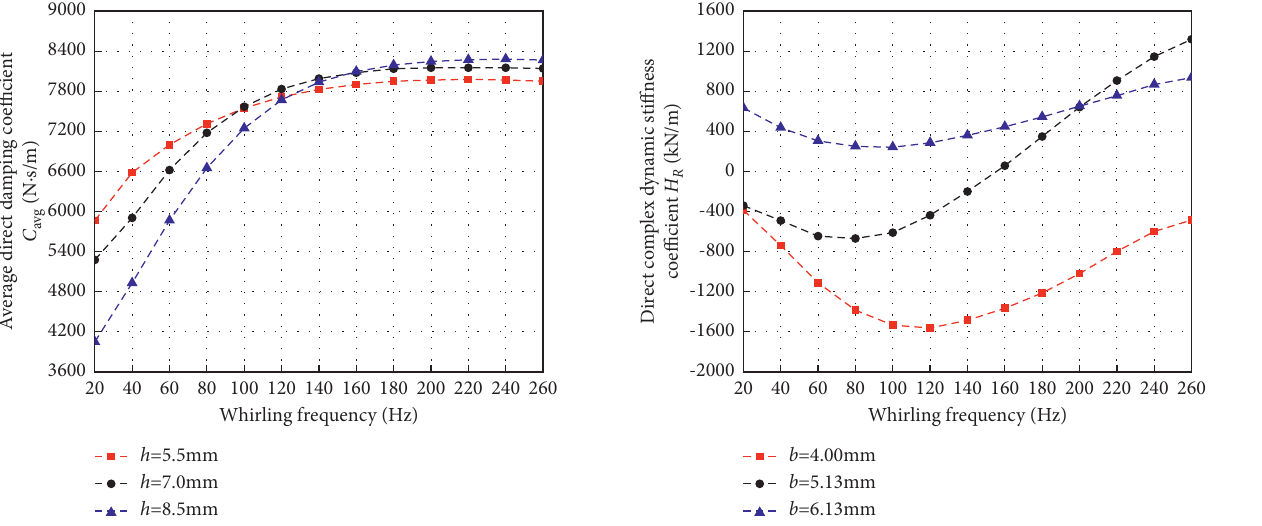
Figure 18: Average direct damping coefficient vs. whirling frequency.